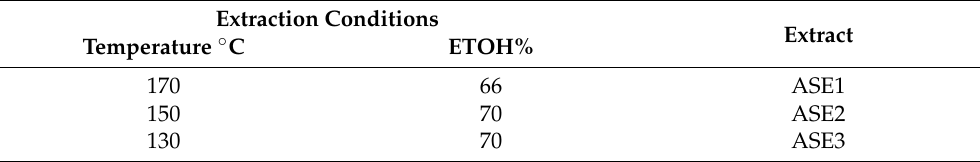
Table 2. Extraction conditions of chaga using accelerated solvent extraction